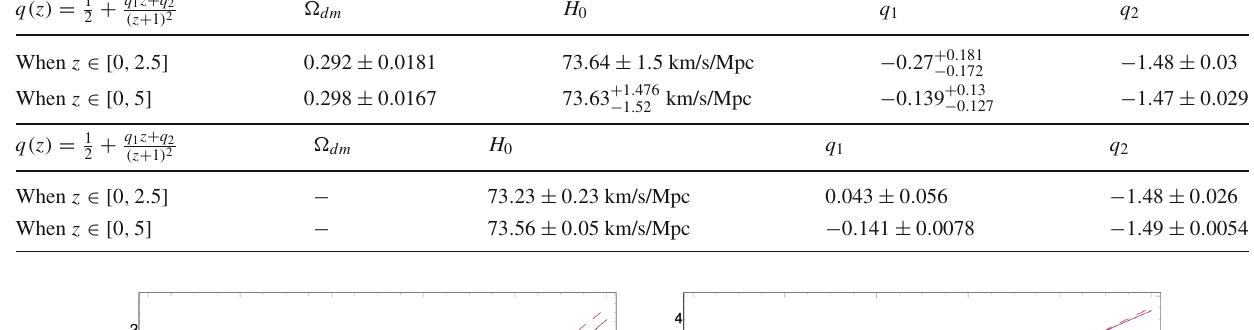
in the generative process. In our analysis we used (cid:8) dm ∈ [ 0 . 2 , 0 . 5 ] , We refer to the PyMC3 documentation for more details on how the marginalization and the error estimations can be achieved during the learning process